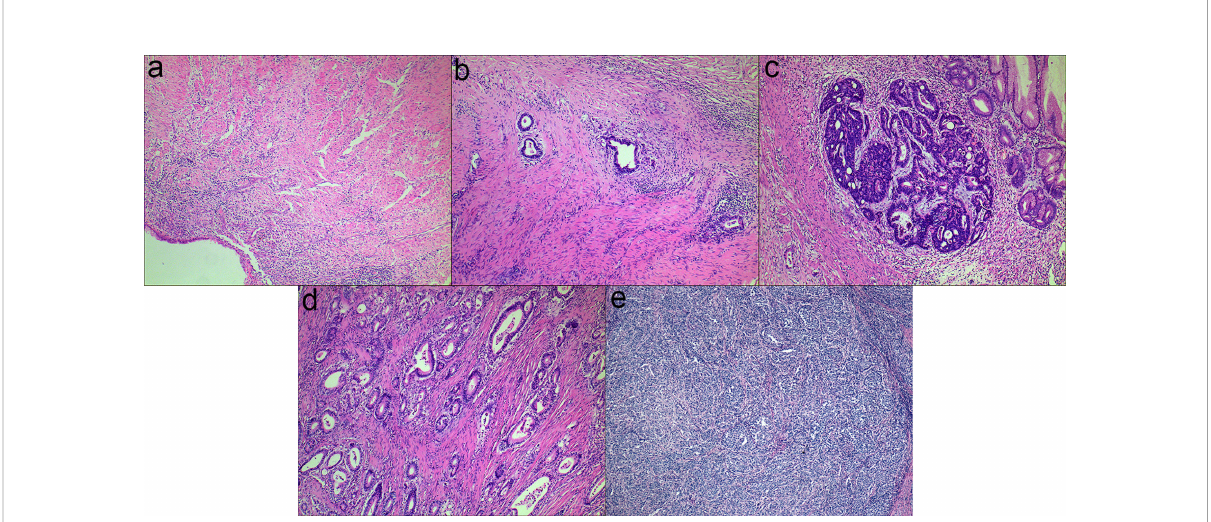
FIGURE 1 Examples of Mandard TRG (a-e): (A) TRG 1, complete tumor regression; (B) TRG 2, rare residual tumor; (C) TRG 3, more residual tumor but less than fi brosis; (D) TRG 4, residual tumor with signs of regression; (E) TRG 5, residual tumor without